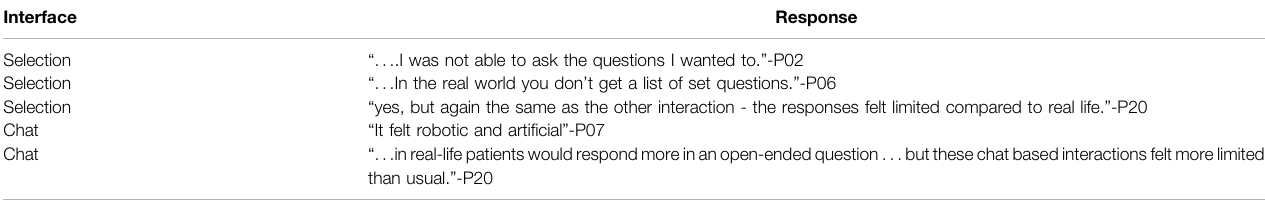
TABLE 4 | Sample student response to “ Did the interview with the [interface] feel like a real-world interview? please explain why or why not ” .